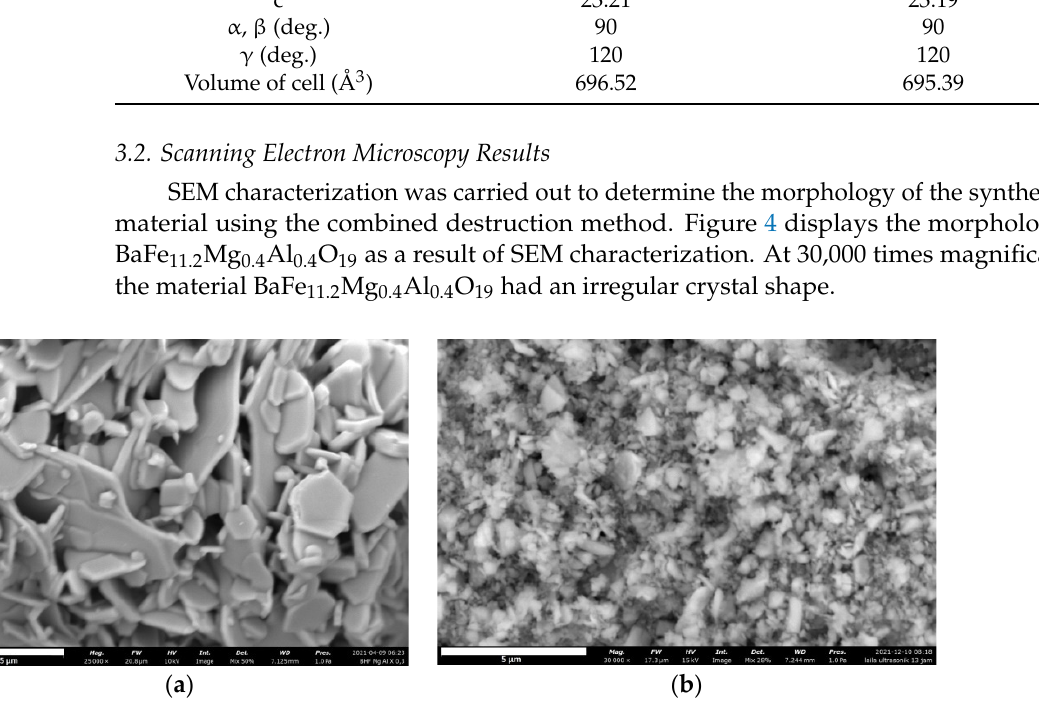
Figure 4. Micrograph SEM BaFe 11.2 Mg 0.4 Al 0.4 O 19 : ( a ) re-milling; ( b ) sonication at 8